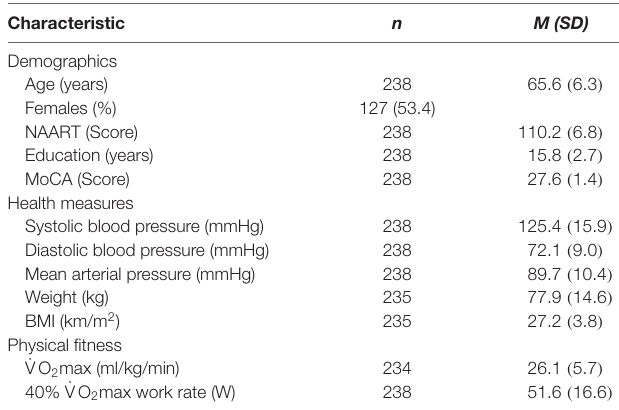
TABLE 2 | Participant characteristics, values represent means ( SD